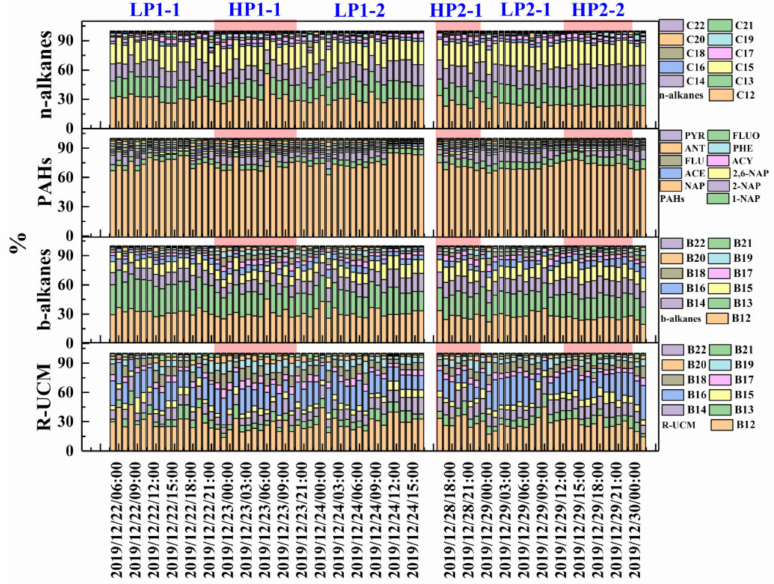
Figure 4. Temporal variations of the fractional contributions of individual species in n -alkanes, PAHs, b -alkanes, and R-UCM in IVOCs (heavy pollution with PM 2.5 > 150 µ g · cm − 3 was defined as HP; light pollution with PM 2.5 > 150 µ g · cm − 3 was defined as LP; HP/LP in P1 and P2 were defined as HP1/LP1 and HP2/LP2,